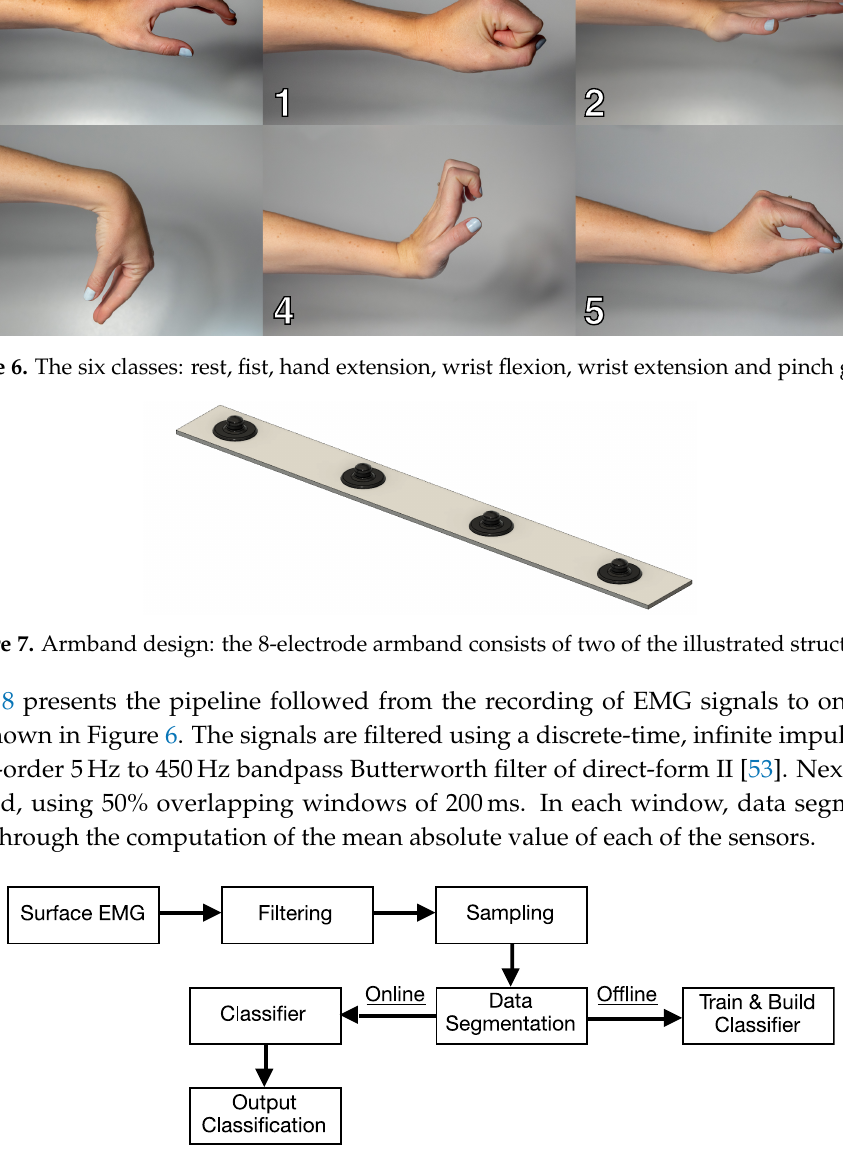
Figure 8. Pipeline from signal acquisition to